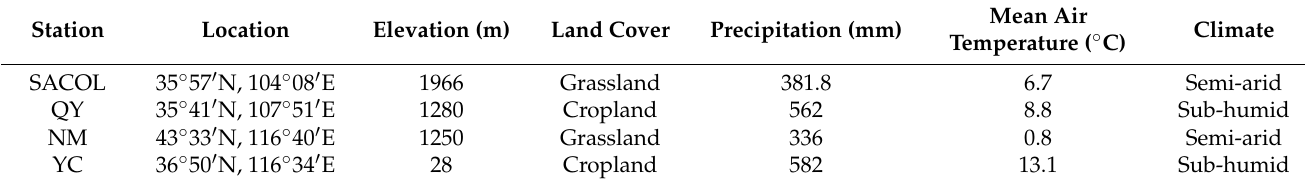
Table 1. Brief description of the soil moisture observatories.